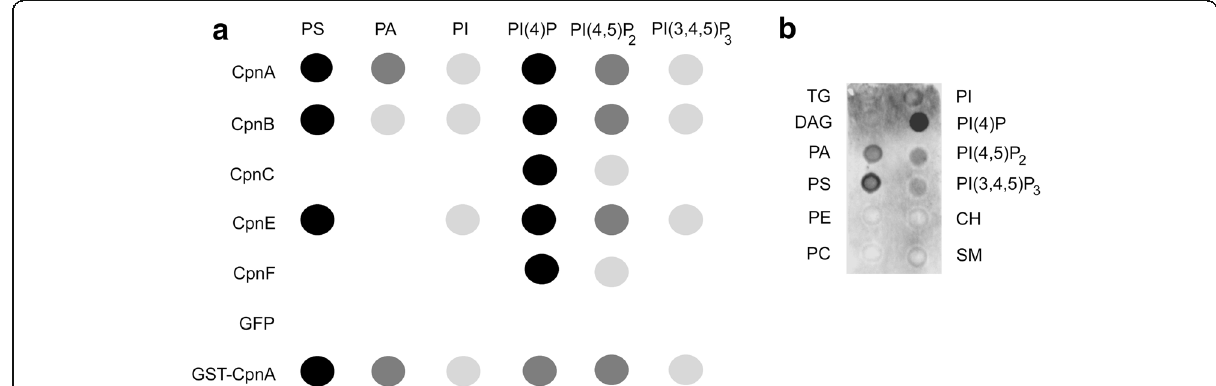
Fig. 7 Copines vary in their binding to specific acidic phospholipids. GFP-tagged copines were isolated by immunoprecipitation and the protein/ antibody complex was incubated with commercially available lipid dot blots in the presence of calcium. Binding was detected with a secondary antibody conjugated to HRP and chemiluminescence. a Multiple blots for each copine protein were analyzed and the combined data is represented as grayscale dots, with white referring to no signal observed and black referring to the most intense signal. b An image of a single dot blot